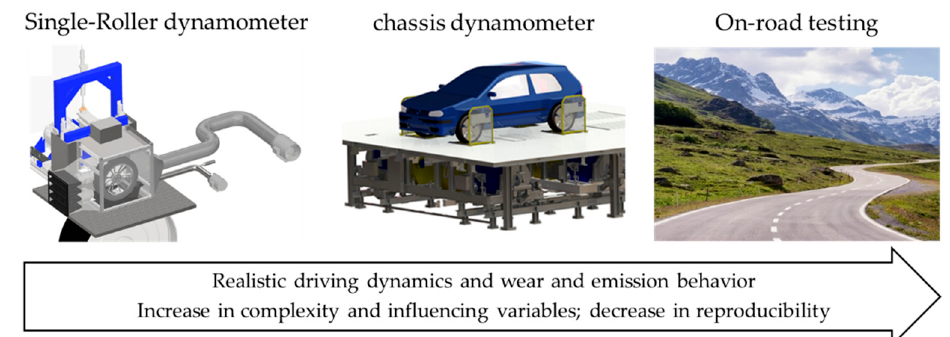
Figure 1. Test environments for detecting tire wear particles.